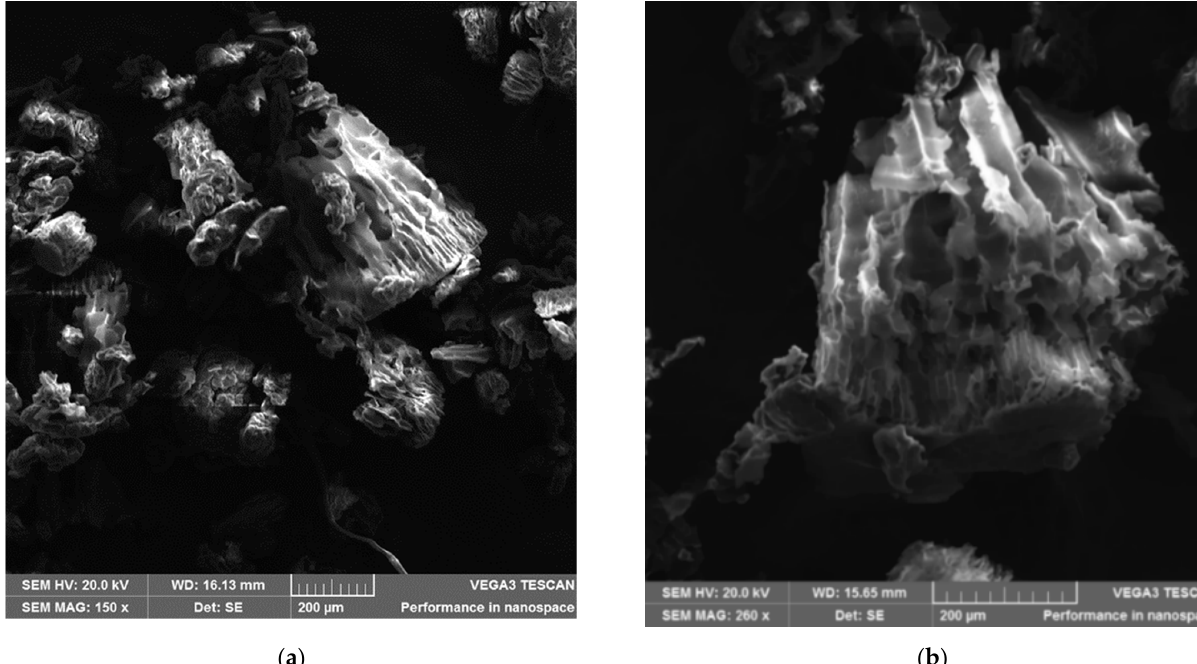
Figure 6. SEM images revealing the retained porosity of the crushed mesoporous neat PAN monoliths: ( a ) reveals various pieces of the crushed monolith with the porous network intact; ( b ) reveals a close-up of one of the crushed particles also with the finger-like pores still intact.